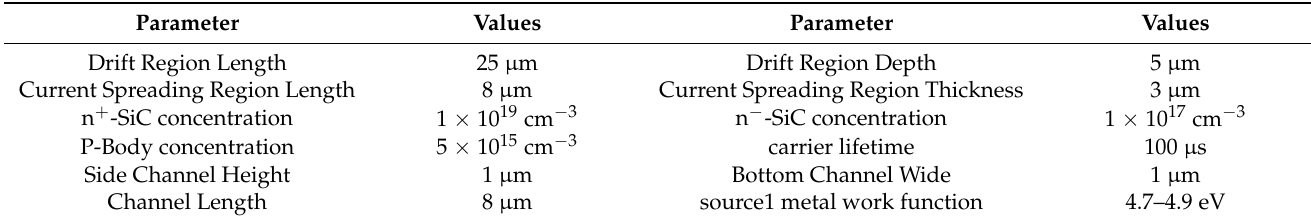
Table 1. Key parameters for SiC TED MOS with